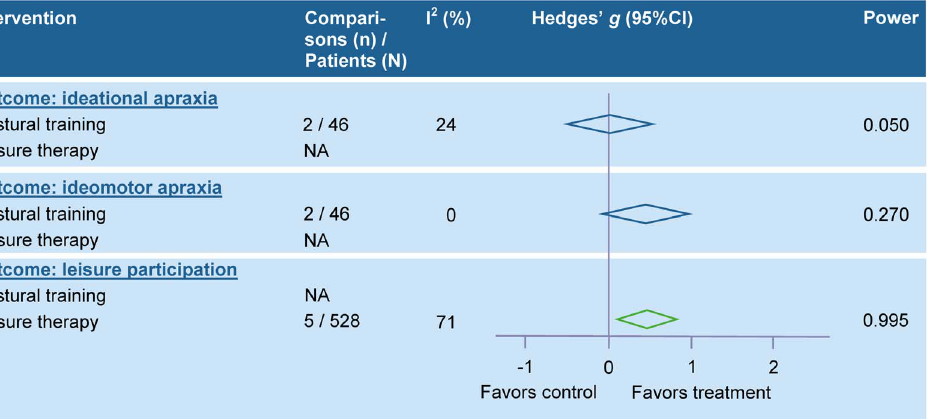
Figure 5. Summary effect sizes for physical therapy interventions – activities of daily living. Legend: A green colored diamond indicates that the summary effect size is significant, while a blue colored diamond indicates that the summary effect size is nonsignificant; CI, Confidence interval; NA, Not applicable.